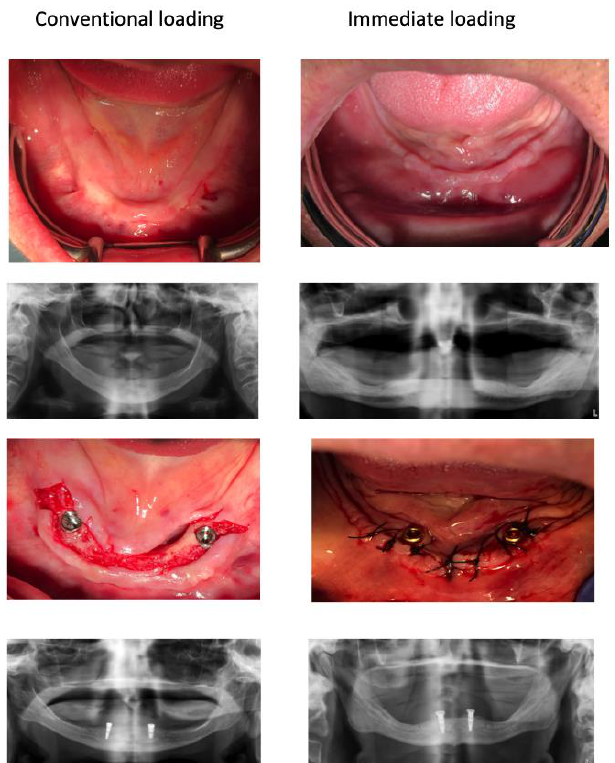
Figure 1. Pre-operative and immediate post-operative clinical and X-ray observations of a representative case of each group. After two months both groups were indistinguishable.